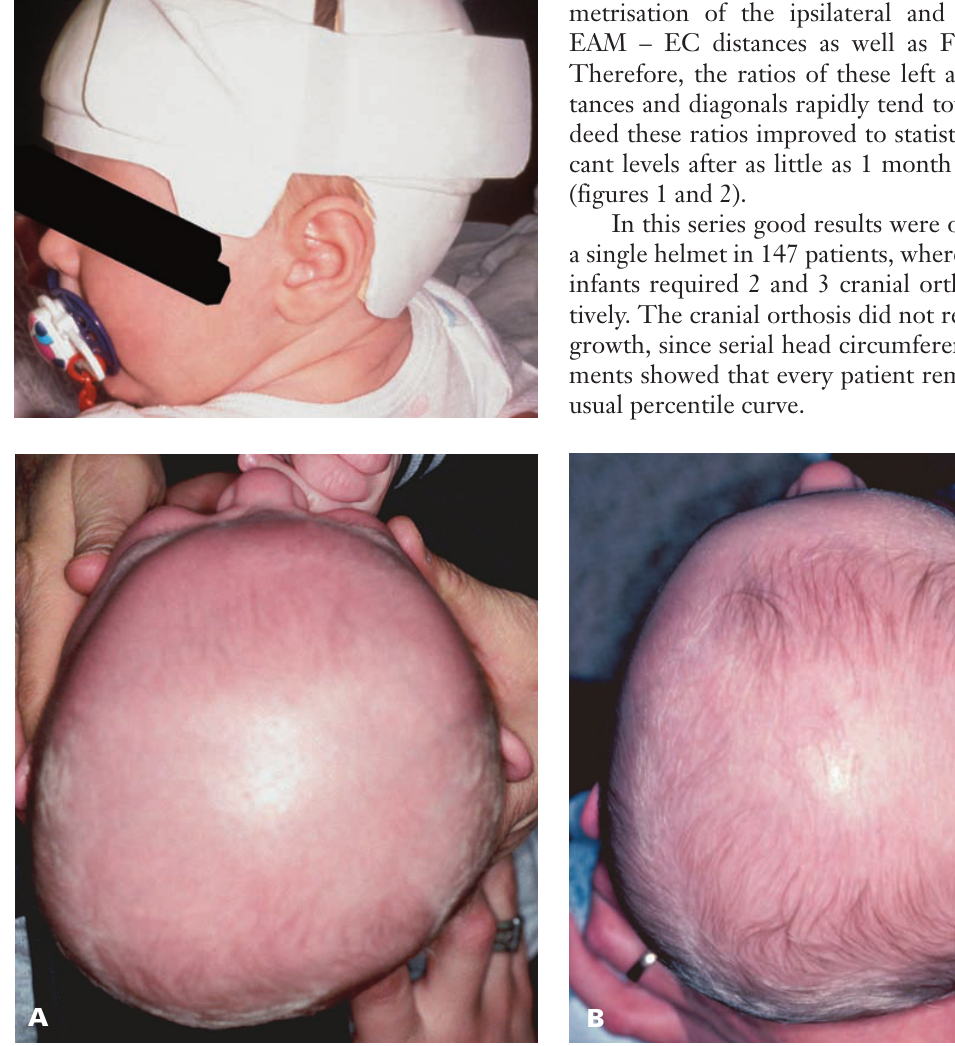
Side view of an in- fant wearing a cranial remodelling helmet.